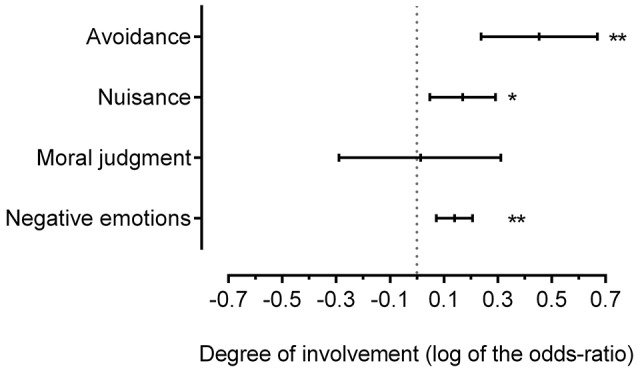
Influence of the degree of involvement on aversive reactions (log of the odds-ratio, LOR and 95% confidence interval CI; the “avoidance” measure is a reversed one). The degree of involvement implies 3 ordinal modalities: participant herself (high degree of involvement), participant's sib (intermediate) and third-party (low). If LOR = 0: the degree of involvement does not affect the odds of outcome; LOR > 0: the degree of involvement is associated with higher odds of outcome; LOR < 0: the degree of involvement is associated with lower odds of outcome. *p < 0.05; **p < 0.005.